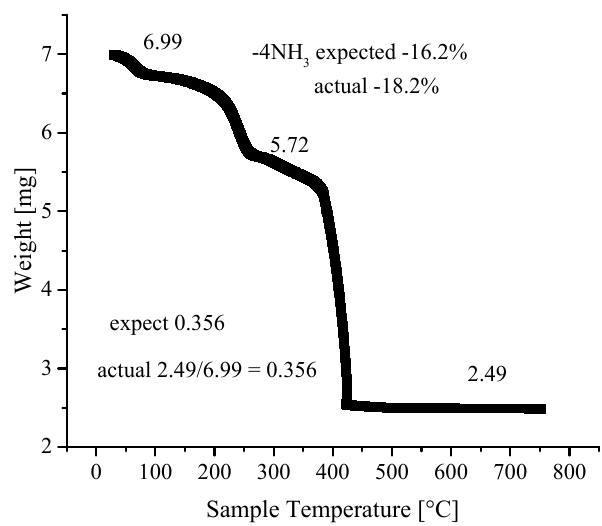
Figure 25. TGA scan in air for neat crystals of Ni-Naph. Loss of NH 3 occurs in two steps out to 300 °C followed by immediate decomposition of the material. (The initial small weight loss at low temperature may also indicate some impurity in the bulk sample as discussed in the main text.) The “expected” value on the plot is the expected ratio of the mass of residual NiO to the mass of the framework as determined from the structure determined by single-crystal X-ray diffraction, whereas the “actual” ratio is the experimentally determined value taken at the indicated points in the scan. See Experimental Section for an explanation of how the ratio is calculated.